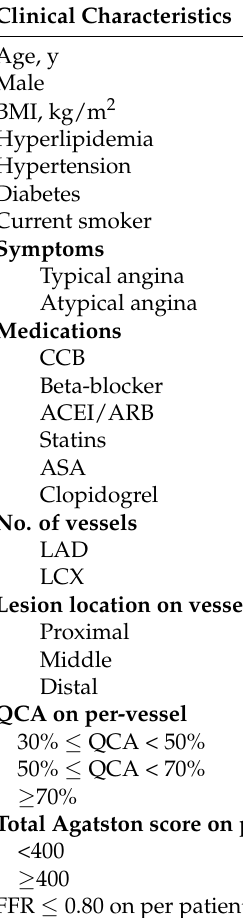
Table 1. Baseline characteristics of the study